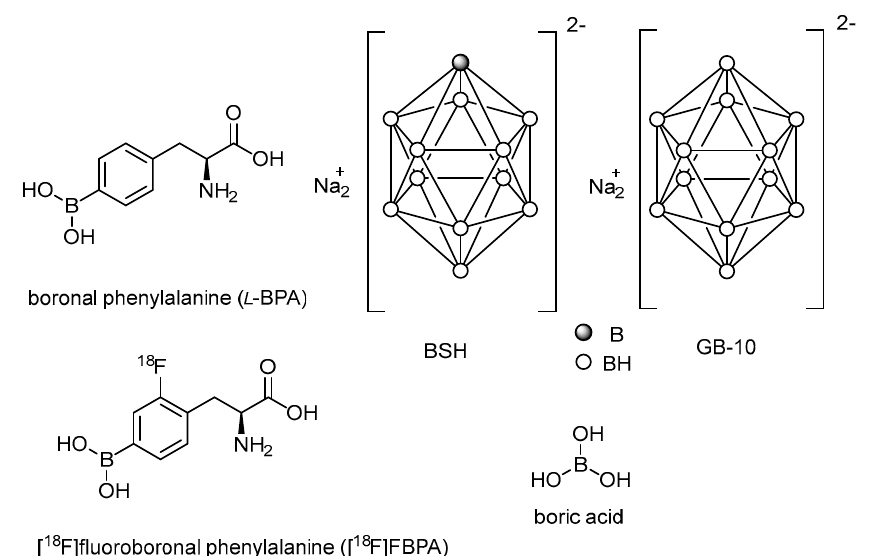
Figure 1. Most recently developed boron carriers for BNCT.